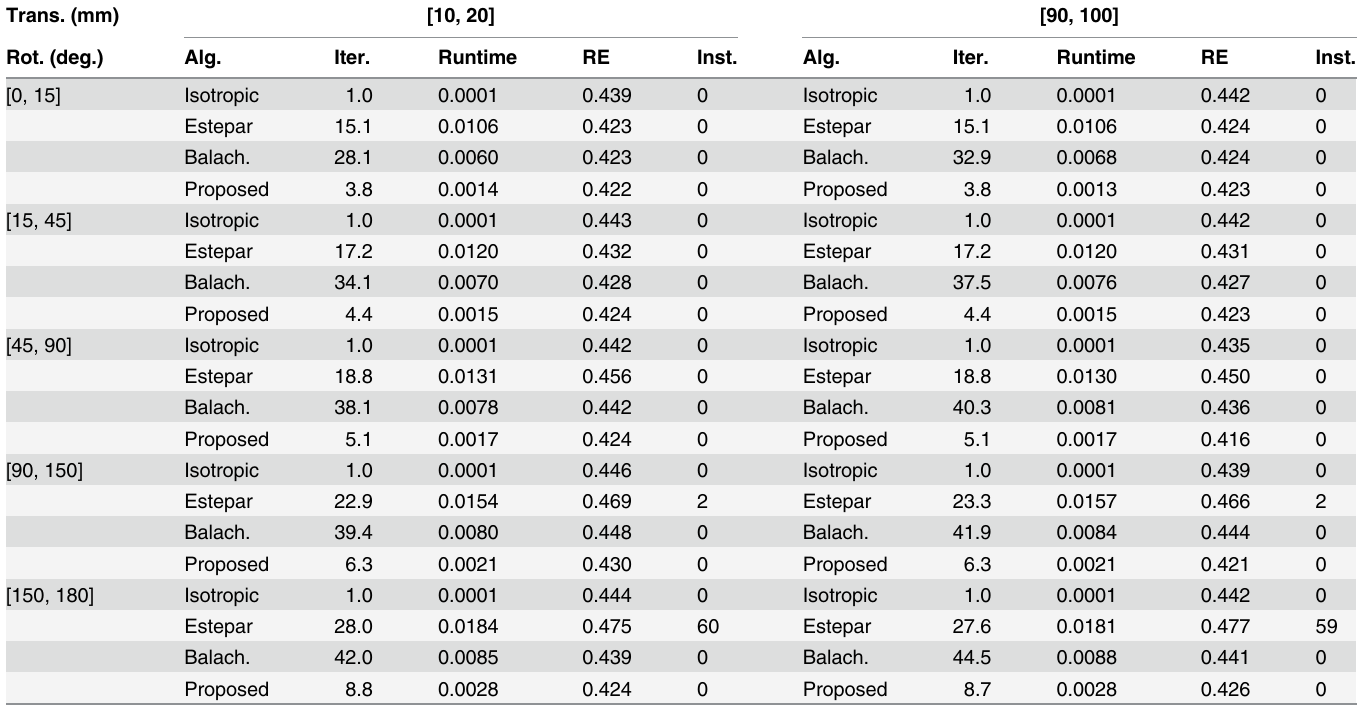
Table 1. Rigid-body registration results for corresponding point sets with anisotropic noise present in both sets of points. (Experiment 1A). Trans. (mm) Rot. (deg.) Alg.